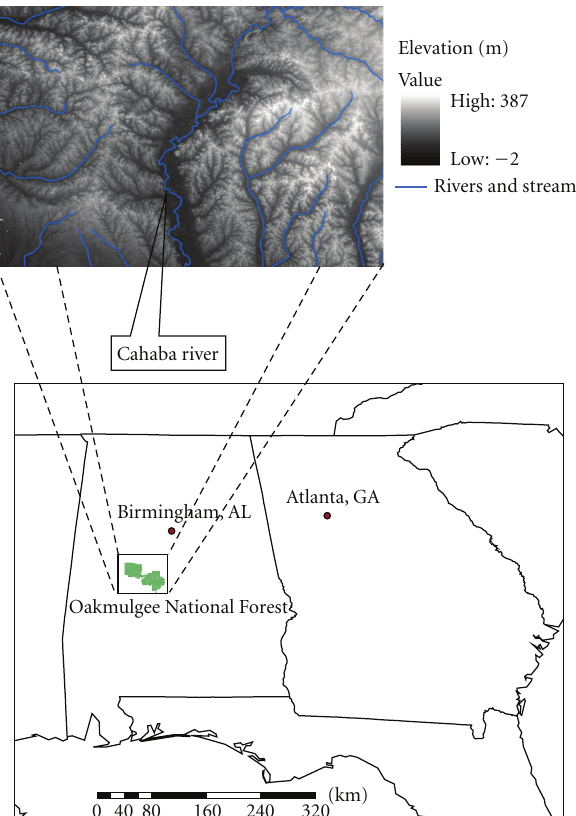
Table 1: Landsat Thematic Mapper